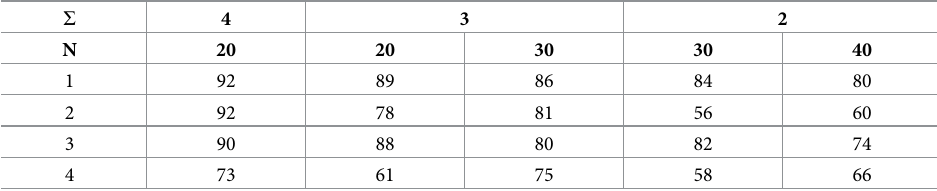
Table 1. Percentage of correct results for different design of virtual samples.